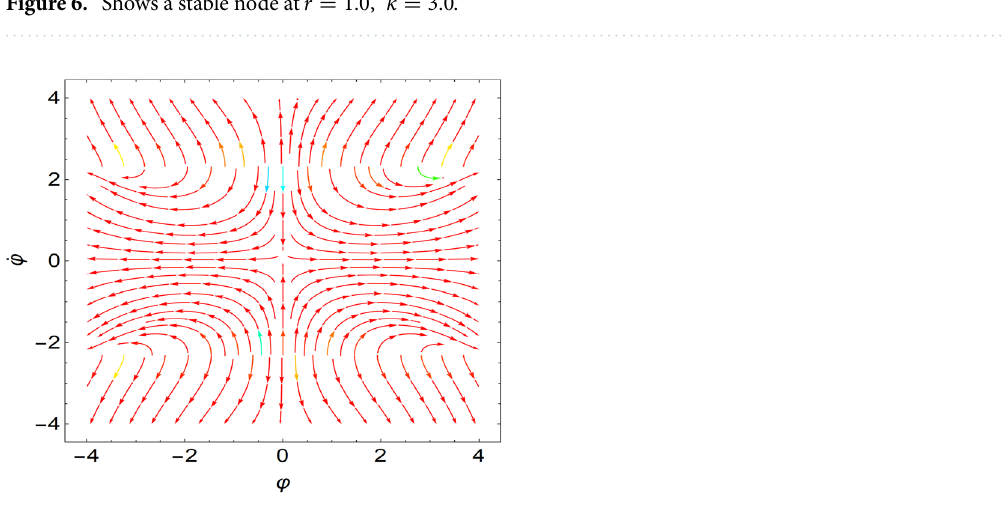
Figure 6. Shows a stable node at r = 1.0, k = 3.0 .